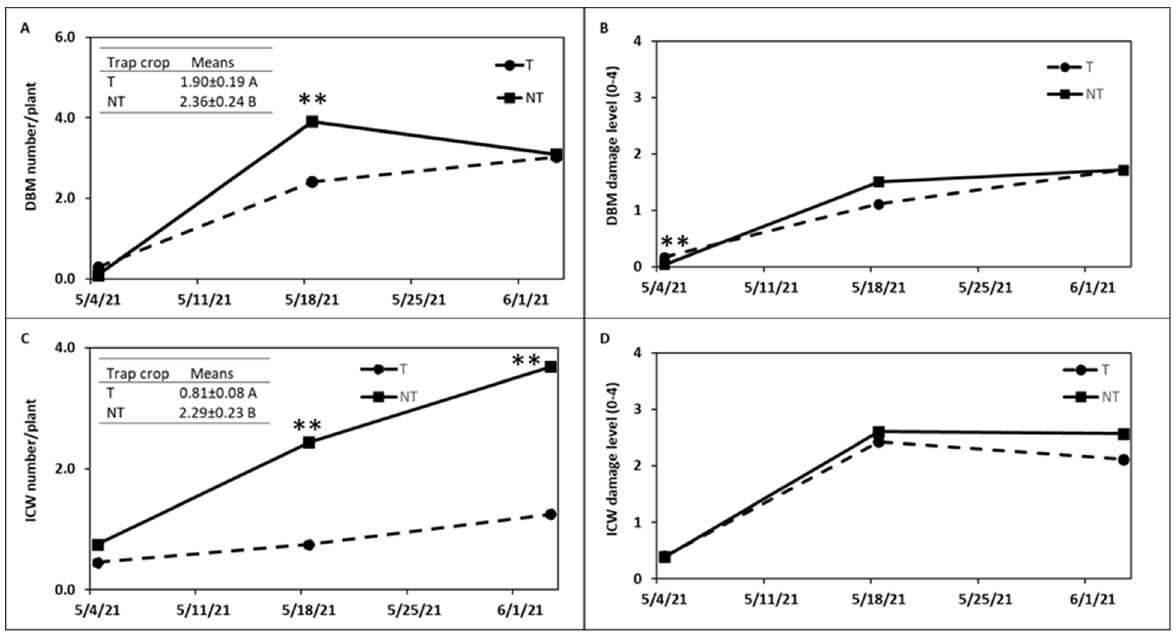
Figure 8. Effect of kai choi as a trap crop on ( A ) Abundance of DBM; ( B ) Percentage of leaves with DBM damage; ( C ) Abundance of ICW; ( D ) Percentage of leaves with ICW on head cabbage in Trial II. ** indicate significant difference between trap crop (T) and no trap crop (NT) at p ≤ 0.05 and 0.01, respectively. Means followed by the same letters are not different based on analysis of variance.